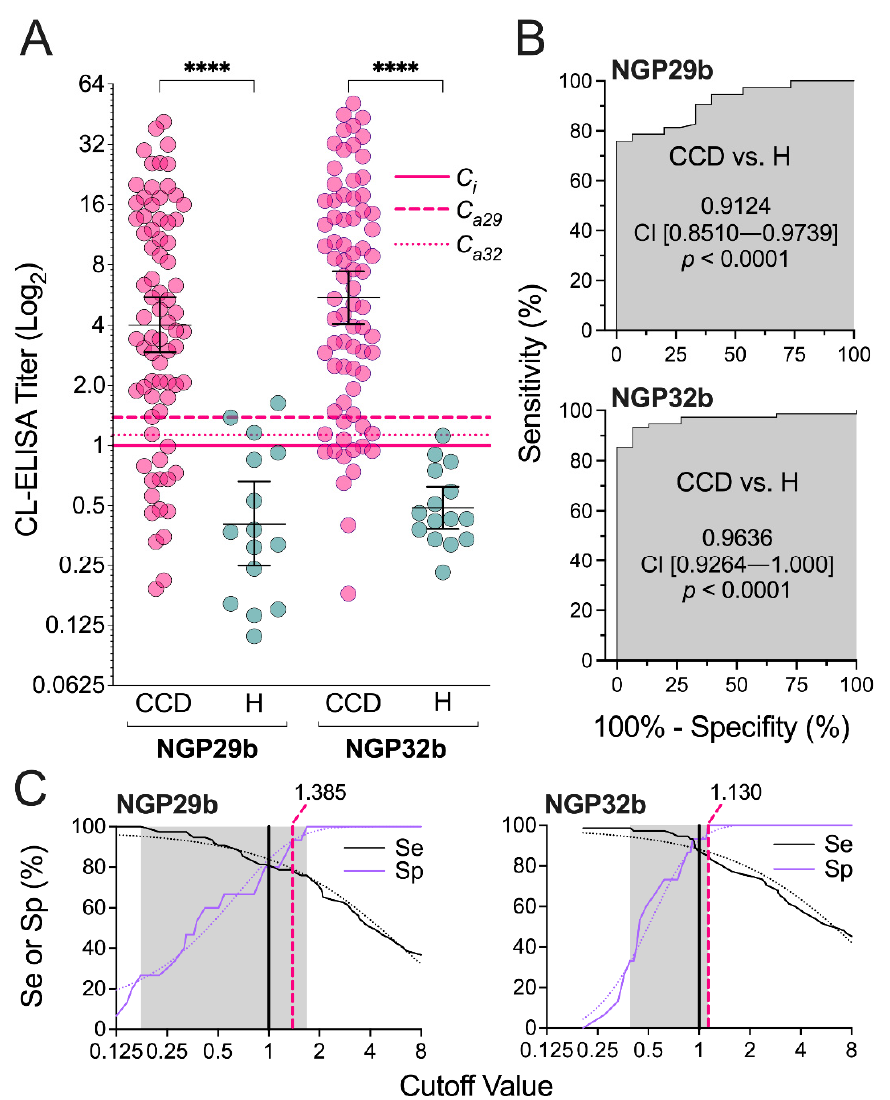
Figure 3. CL-ELISA reactivity of NGP29b and NGP32b with sera from individual patients with CCD, or from healthy individuals. Sera (at 1:800 dilution) from individual patients with CCD, or from healthy (H) individuals were evaluated against NGP29b , and NGP32b , each at 50 ng/well. CL-ELISA was performed as described in the Supplementary Material. ( A ) Grouped scatter plot analysis of sera from CCD patients, or H individuals with NGP29b or NGP32b . Solid red line, C i , initial cutoff value (titer = 1.000), calculated as described in the Supplementary Material. Discontinued red line ( C a29 ), adjusted cutoff value for NGP29b ; dotted red line ( C a32 ), adjusted cutoff value for NGP32b ; these cutoffs were calculated based on the ROC and TG ‐ ROC curve analysis data in B and C , below. Statistical analysis: Nonparametric Mann–Whitney test; significance level: p < 0.05. ****, p < 0.0001. ( B ) ROC curves for NGP29b , and NGP32b , comparing the reactivity of sera from CCD infections with H individuals, using the data depicted in the scatter plots ( A ). AUC, area under the curve is indicated (grey area). In brackets, 95% confidence interval (CI) values are indicated. ( C ) TG ‐ ROC curve analysis was performed by plotting the ROC data ( B ) for sensitivity (Se) and specificity (Sp), as described by Greiner et al. [51]. Shaded area indicates the cutoff value interval where Se or Sp could reach 100%. The Se (black) and Sp (purple) raw data points are represented as thick lines, whereas the fitted data are indicated as fine lines. Vertical black lines, initial titer cutoff value ( C i = 1.000); vertical dotted red line, adjusted cutoff values.